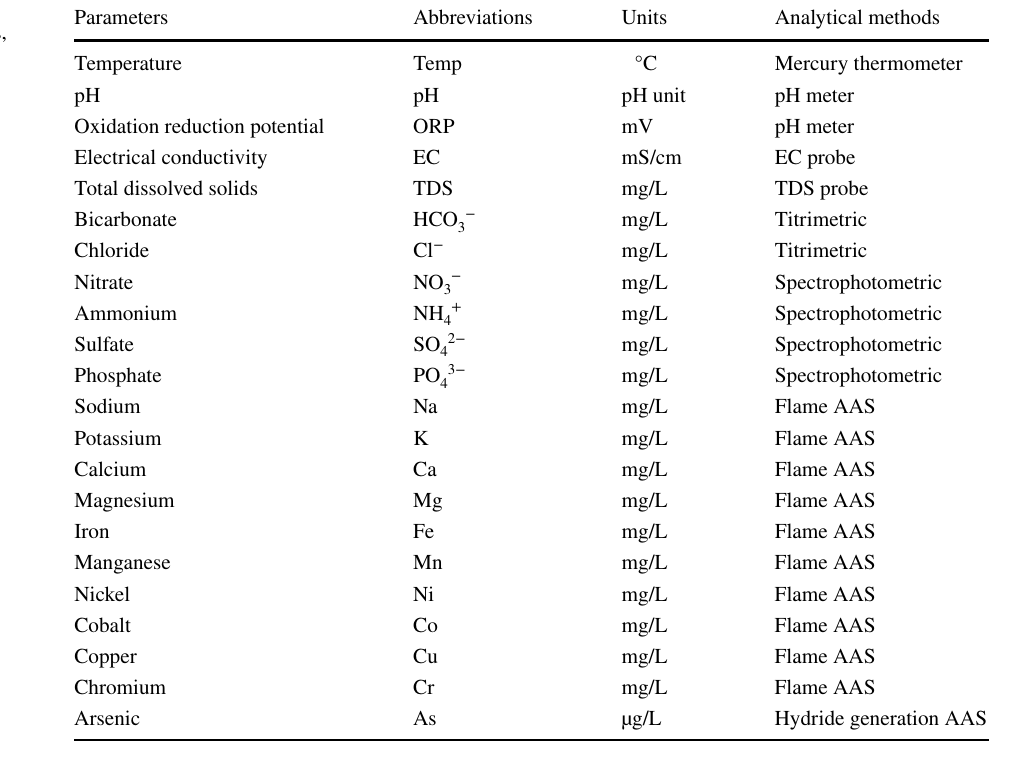
Fig. 1 Scree plots of the eigen- values from PCA during the pre-monsoon